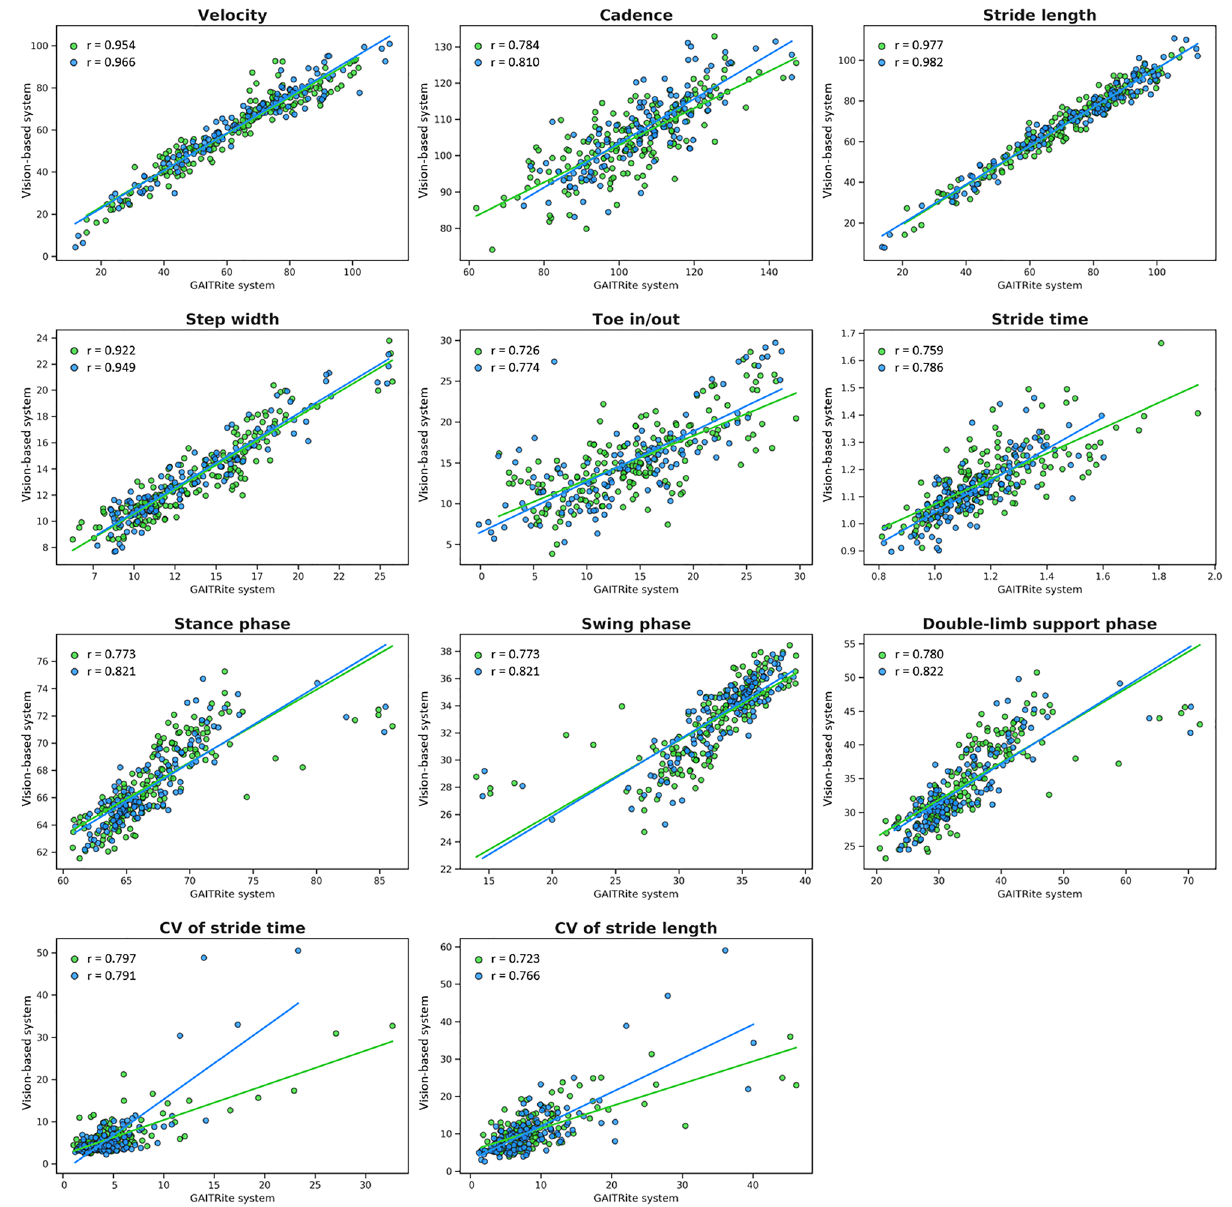
all parameters before and after the CSFTT. Green dots indicate data before the CSFTT while blue dots indicate data after the CSFTT. CSFTT, cerebrospinal fluid tap test; CV, coefficient of